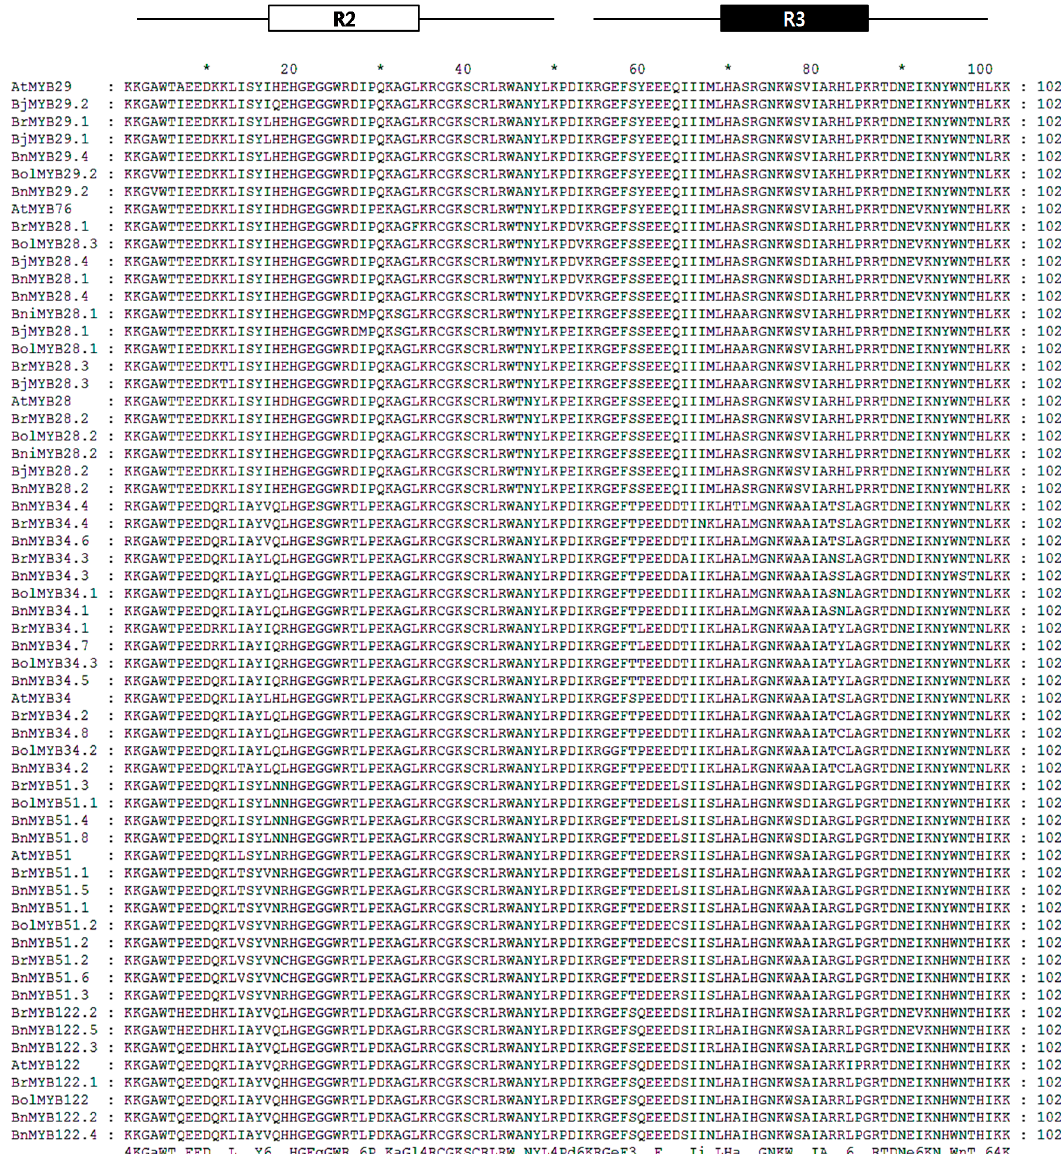
Figure 2. Amino acid sequence alignment of the R2R3 MYB DNA domains in 55 glucosinolate biosynthetic transcription factors in Brassica species. The R2 and R3 binding domains are boxed in white and black, respectively. At, A. thalinala ; Br, B. rapa ; Bni, B. nigra ; Bol, B. oleracea ; Bn, B. napus ; Bj, B. juncea .